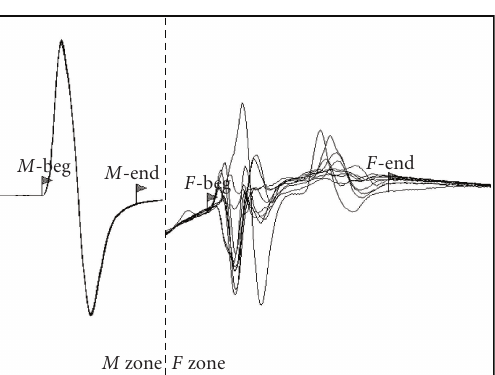
Figure 3: SRNS of the right tibial nerve of ferret N.5. 2ms/Div; 2mV/Div. Stimulation rate of 2Hz. Table 2: Values of F waves of tibial nerve stimulated at the tarsus.